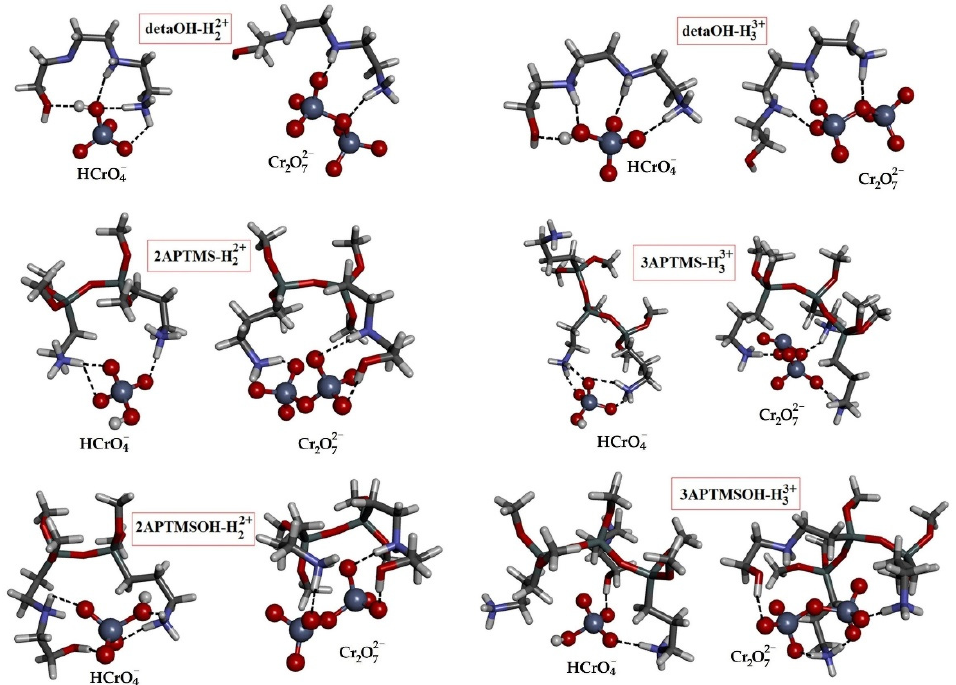
Figure 12. The optimized structures of dimers, used to estimate the energies of interactions between hydrogen chromate or dichromate ions and cationic sorption sites.